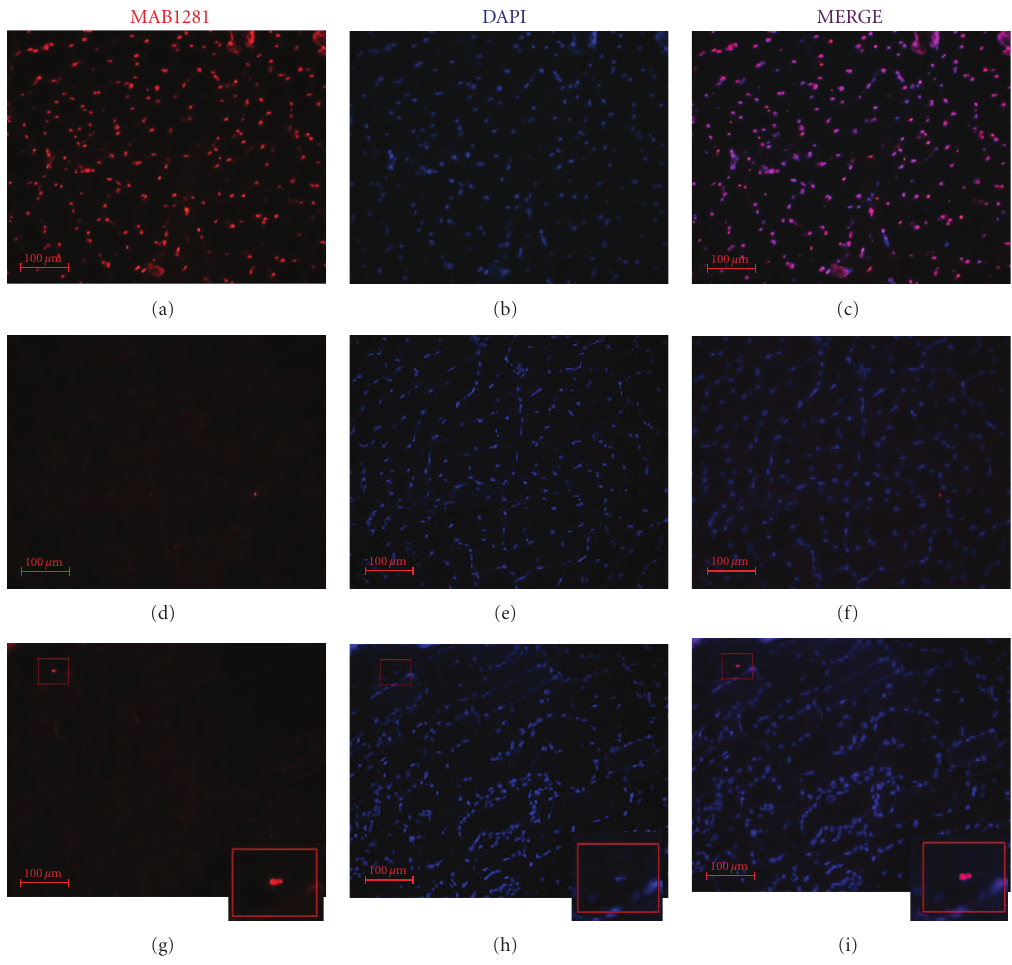
Figure 2: Presence of human nuclei at recipient dog muscle after umbilical cord MSCs transplantation. Scattered human cells into biceps femoralis (B312) of a ff ected female L3F2 identified by the antihuman nuclei antibody MAB1281. Preparations were counterstained with 4 (cid:3) , 6-diamidino-2phenylindole (DAPI). (a–c) human muscle; (d-e) nontransplanted canine muscle; (g-h) B312 from L3F2. Insets in (g-h) show details of human nucleus. Images were acquired with the same exposure time and magnification of